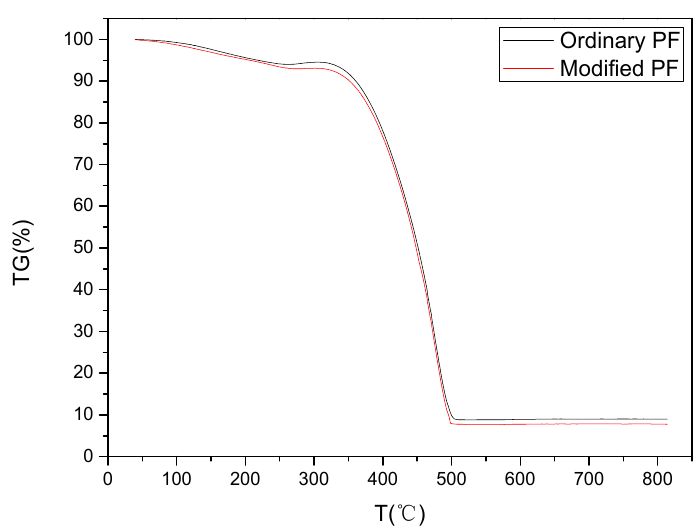
Figure 13. The TG of the ordinary PF and modified PF (the amount of 3-pentadecyl-phenol is 15% of the total amount of phenol).